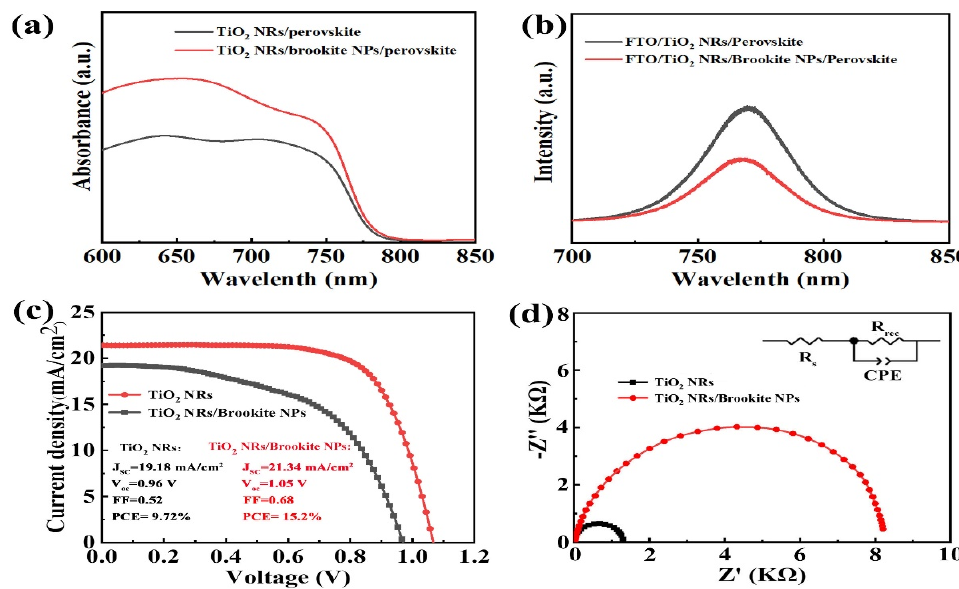
Figure 5. ( a ) UV–vis absorption spectra of the TiO 2 NR/perovskite film and TiO 2 NR/brookite NP/perovskite film; ( b ) steady-state PL spectra of perovskite film on TiO 2 NRs and TiO 2 NR/brookite NPs, respectively; ( c ) J-V curves of PSCs based on TiO 2 NRs and TiO 2 NR/brookite NPs; ( d ) Nyquist plots of the PSCs based on TiO 2 NRs and TiO 2 NR/brookite NPs.